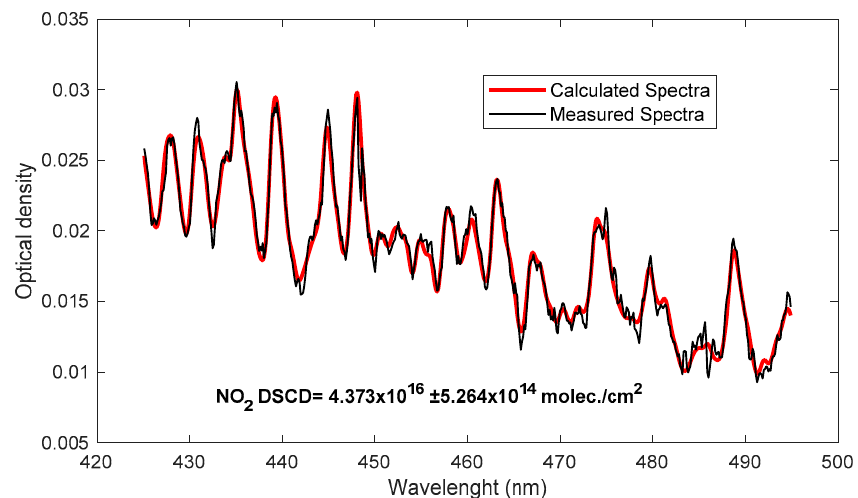
Figure 4. Example of a NO 2 DOAS fit realized with the QDOAS software; the analyzed spectrum was recorded on 4 November 2017, 10:02 local time (LT), horizontal scanning mode (HSM), Solar Zenith Angle = 55°; Red line represents the reference spectra and the black line represents the measured spectra.